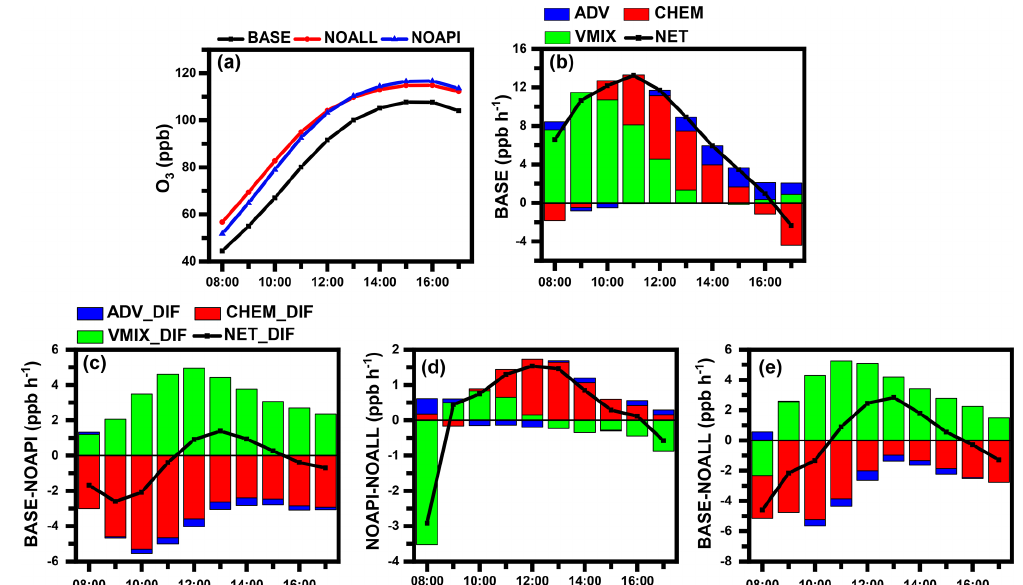
Figure 7. Temporal evolution characteristics of aerosol–radiation interactions on O 3 averaged over the four episodes. (a) Diurnal variations in simulated surface O 3 concentrations in BASE (black dotted line), NOAPI (blue dotted line), and NOALL (red dotted line) cases over CAPAs. (b) The hourly surface O 3 changes induced by each physical/chemical process, using the IPR analysis method in BASE case, are shown. (c–e) Changes in hourly surface O 3 process contributions caused by API (BASE minus NOAPI), ARF (NOAPI minus NOALL), and ALL (BASE minus NOALL) over CAPAs during the daytime (08:00–17:00LST) are shown. The black lines with squares denote the net contribution of all processes (NET; defined as VMIX + CHEM + ADV). Differences in each process contribution are denoted as VMIX_DIF, CHEM_DIF, ADV_DIF, and